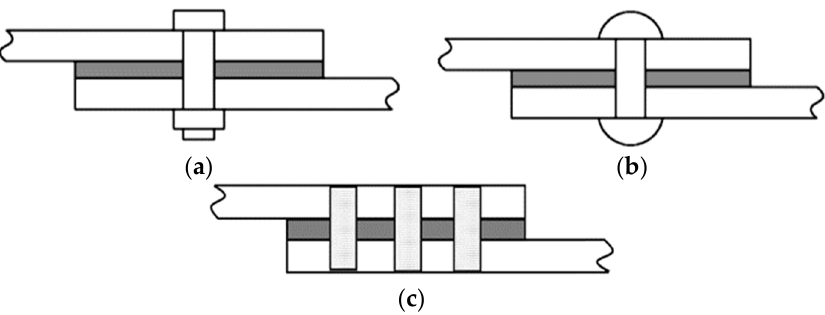
Figure 2. Schematic representations of ( a ) bolted-bonded joint, ( b ) rivet-bonded joint and ( c ) a pin-bonded joint.